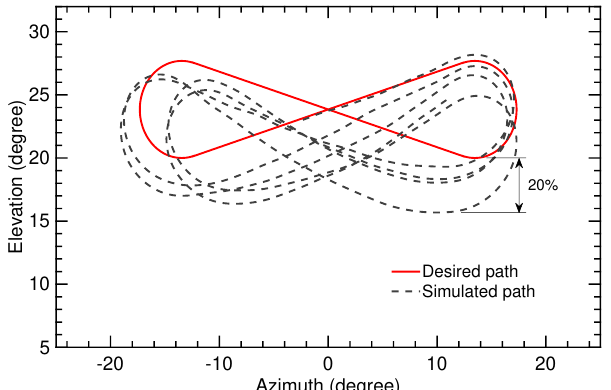
Figure 13. Trajectory computed on the basis of the classical flight controller for flight time of 70